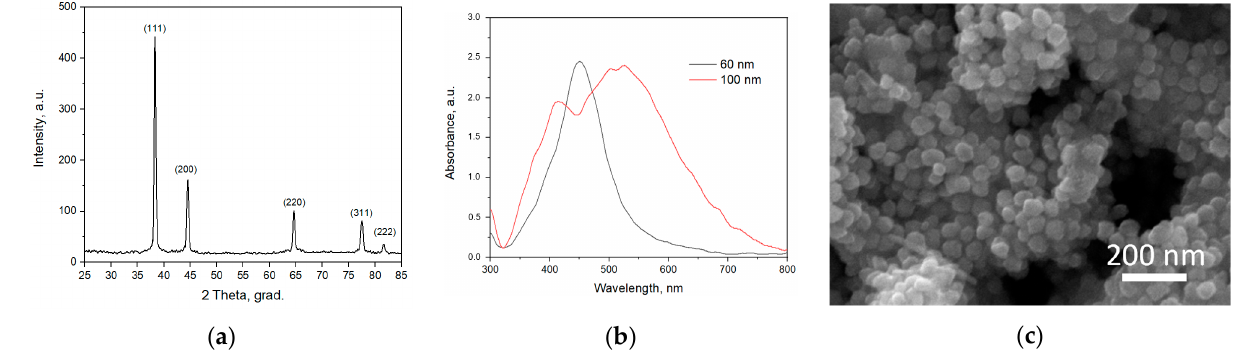
Figure 4. The results of structural and optical characterization of the Ag nanoparticles: ( a ) the XRD pattern, ( b ) the absorption spectra and ( c ) the SEM image.